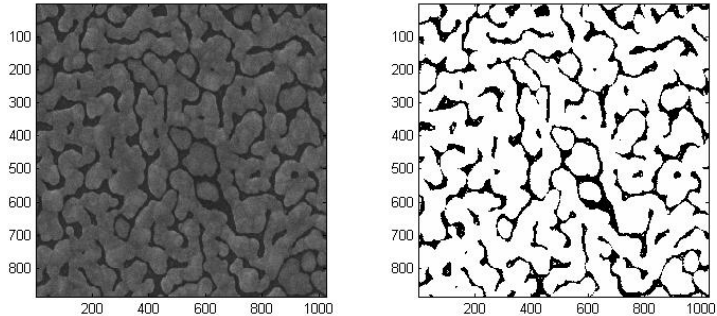
Figure 6. Schematic diagram of SEM image reconstruction. The figure on the left is the original SEM image and the figure on the right is the reconstructed binary image. The numbers on the axes are in nanometer. Table 2. The gap densities and gap widths of samples developed with different conditions. The data shown are the average values of several SEM images taken from each sample.